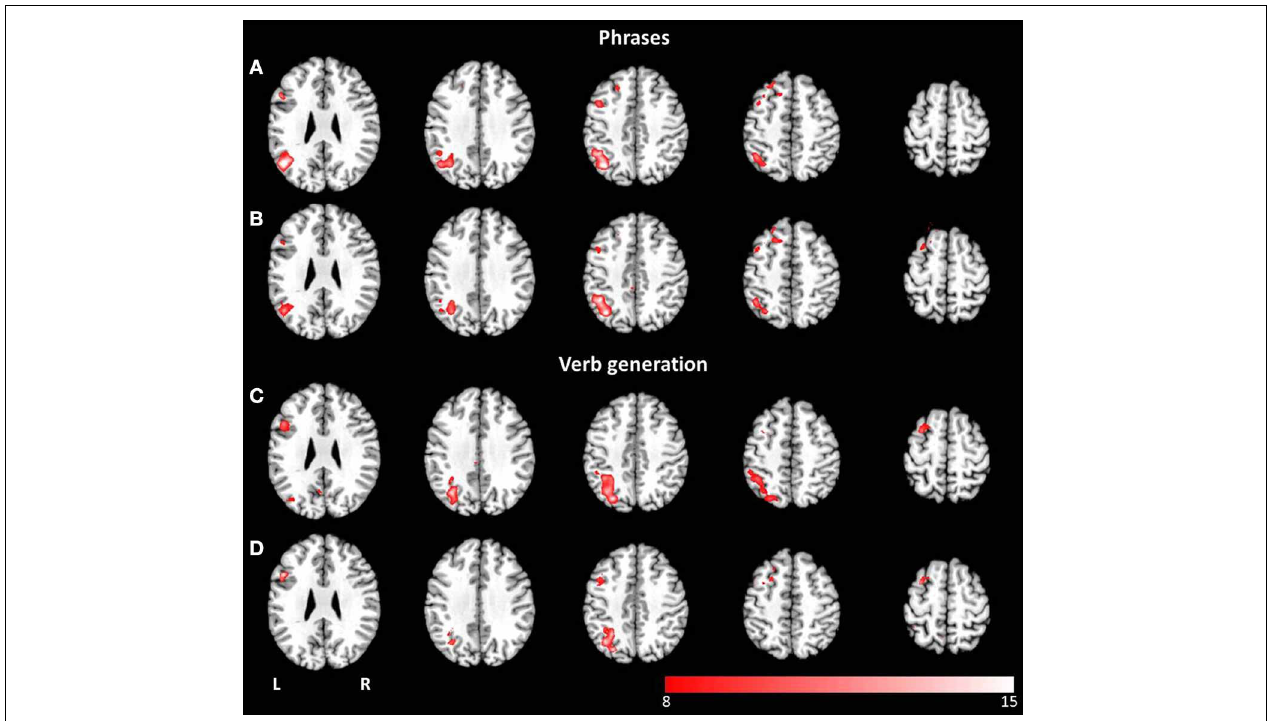
FIGURE 6 | Axial mean anatomical images overlaid with lateralized spatial maps ( p < 0 . 05, FWE-corrected) for the language network resulting from combined group ICA for visual (A,C) and auditory stimulus presentation (B,D). No statistically significant modality-dependent differences were obtained.